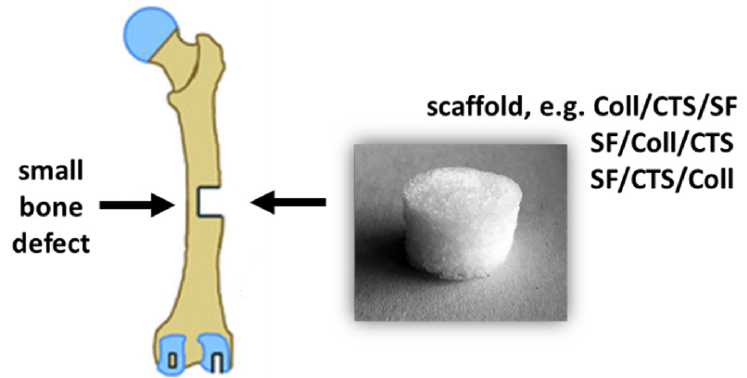
Figure 1. The graphical presentation of the possible use of the material.